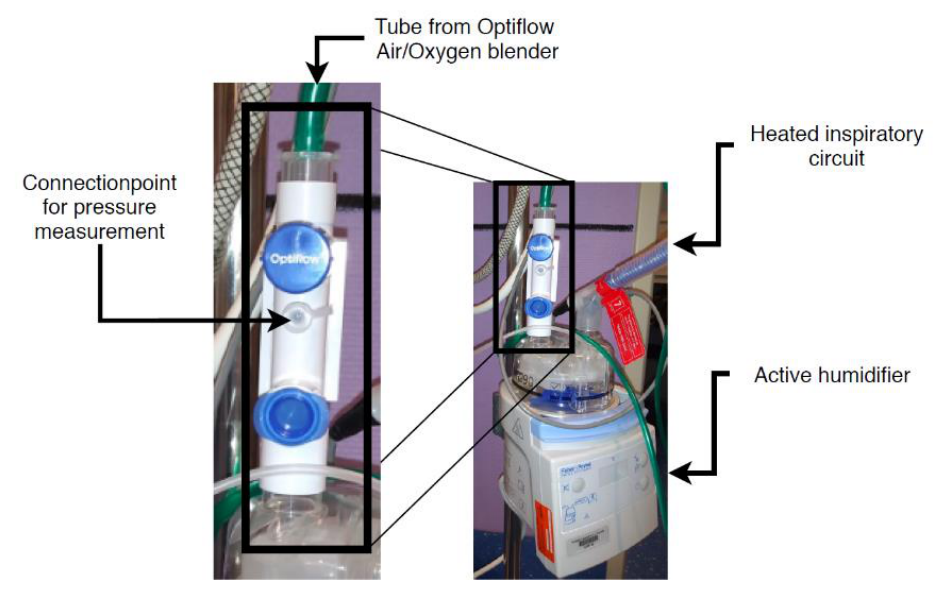
Figure 2. Connection point for pressure measurement on the Optiflow.